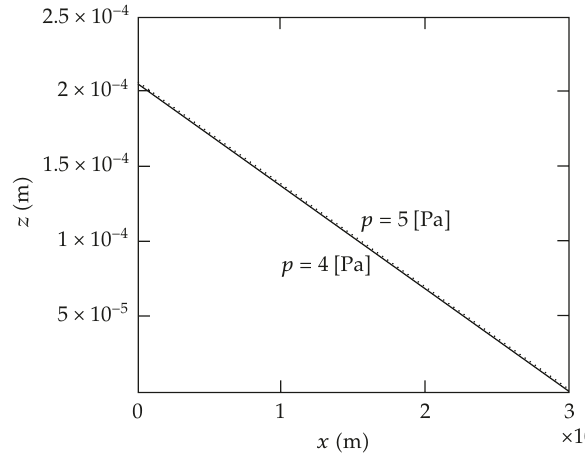
Figure 6: z versus x for p (cid:8) 4; 5 (cid:6) Pa (cid:7) .